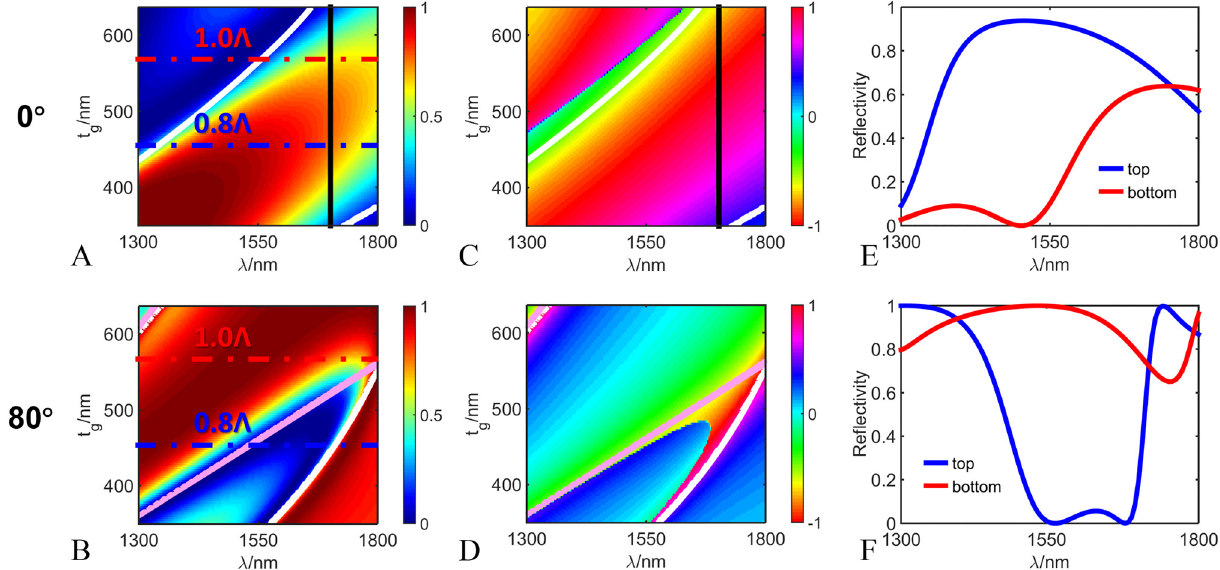
Figure 4: Illustration of the dependence on wavelength and thickness of single-layer meta-grating (MG) at different angles of incidence. (A, B) Reflectivity contour and (C, D) Reflection phase contour (the unit of color bar is π ) of single-layer MG as a function of wavelength and gratingthicknessattheincidentanglesof0 ° and80 ° .Theblacksolidlineisthecut-offwavelengthofthe fi rstorderwaveguidearraymode.The white and pink curves are the collective FP resonance curves of the zeroth and the fi rst waveguide array modes, respectively. (E, F) Complementary re fl ectivity spectra of two single-layer meta-gratings with thicknesses 0.8 Λ and 1.0 Λ , which are the top and bottom sub- gratings of the narrow-frequency sharp-angular fi lter in Figure 3, at the incidence angles of 0 ° and 80 °